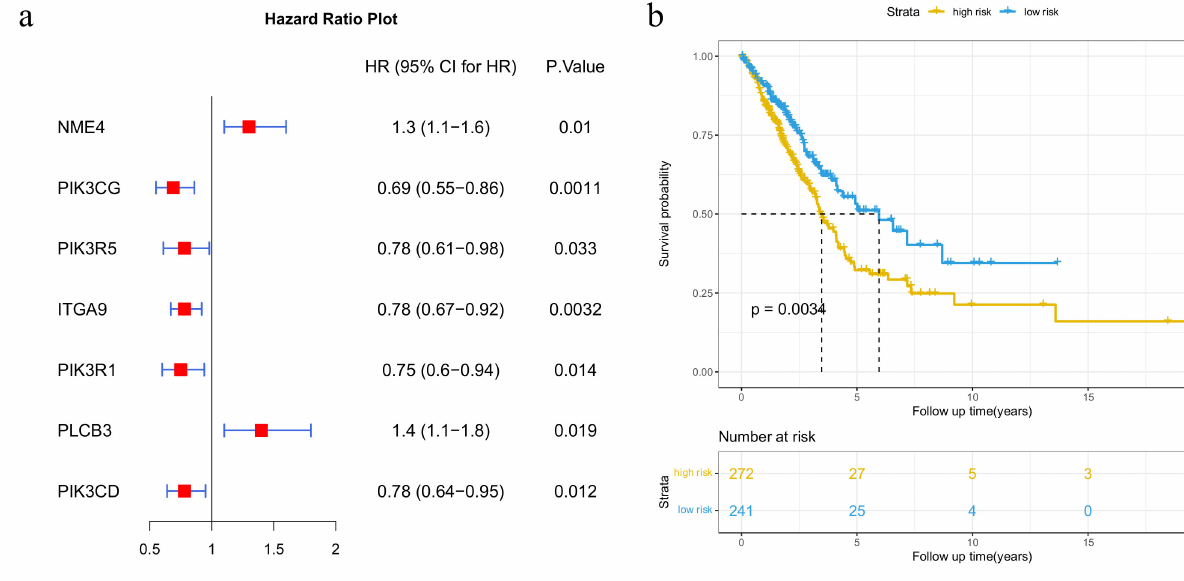
Figure 4. Results of survival analysis of the top 5 genes with the highest-degree potential disease genes. ( a ) Forest plot of 7 genes selected by the univariate Cox proportional hazards regression model; ( b ) Kaplan–Meier survival plots of patients grouped by the median risk score